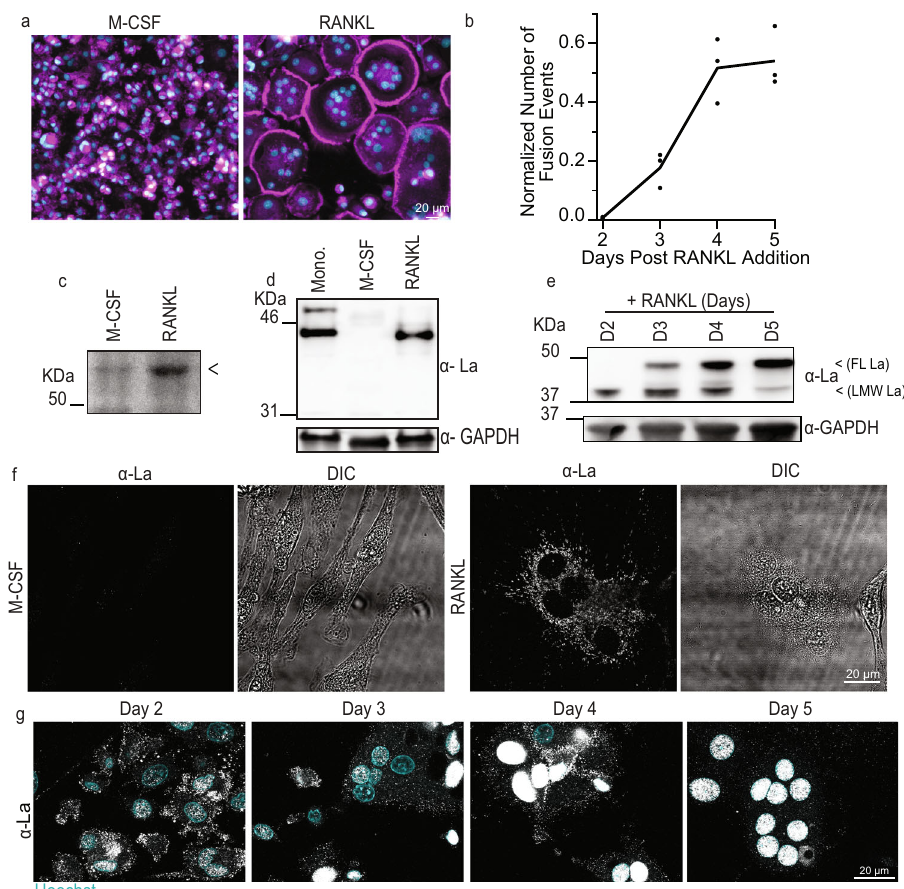
Fig. 1 | Osteoclastogenic differentiation is accompanied by drastic changes in the steady-state levels and localization of La molecular species. a Representative images of stages of osteoclastogenic derivation of human monocytes after M-CSF (6 days, referred to as “ M-CSF ” ) and after M-CSF (6 days) followedbyM-CSF+RANKL(5days, “ RANKL ” ),respectively.(Magenta=Phalloidin- Alexa488, Cyan = Hoechst). b Quanti fi cation of the number of fusion events nor- malized to the total number of nuclei observed over time following RANKL addi- tion. ( n =3) Each point represents an average of >7500 nuclei scored. c Representative Bis-Tris PAGE separation and silver staining of whole protein lysates from M-CSF derived osteoclast precursors and at 3 days post RANKL application. Lysates were ran until the 50 KDa marker nearly ran off the 4 –